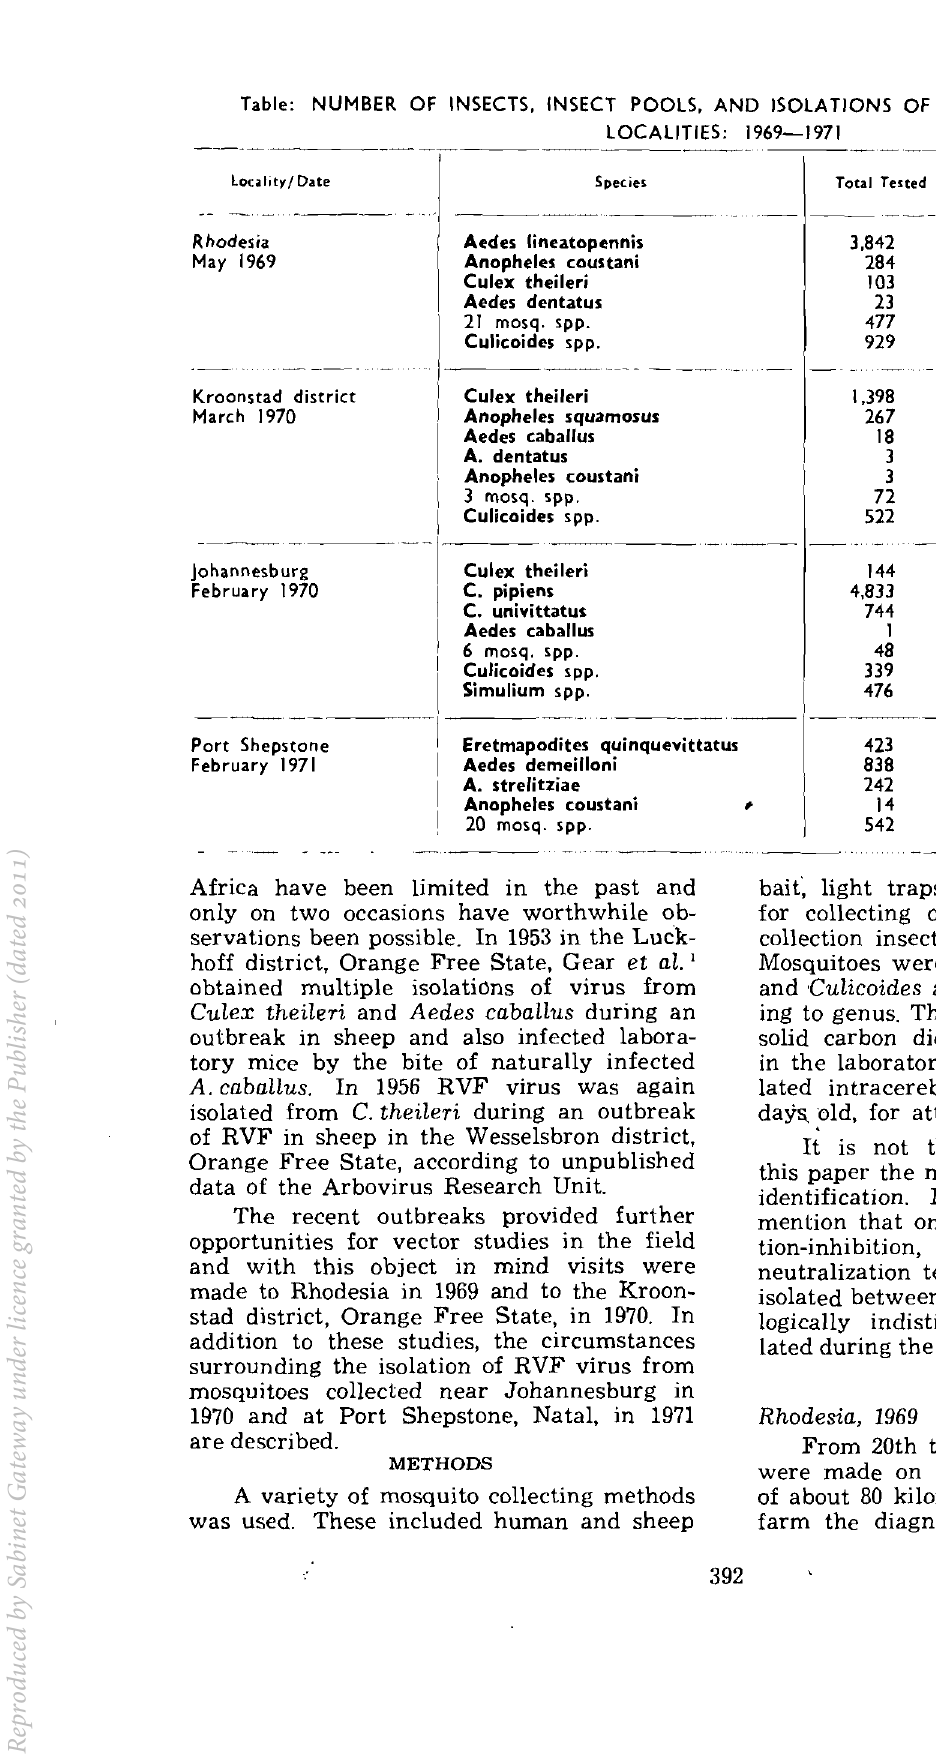
LOCALITIES: 1969-1971